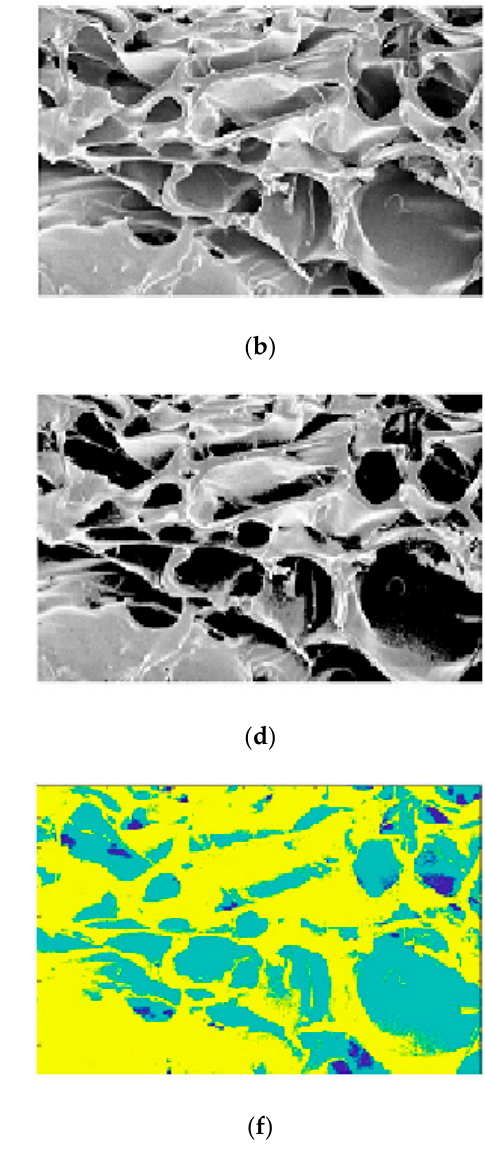
Figure 8. Classification: (Case1) Chitosan image origin ( a ), image enhanced (equalization) ( b ), classification cluster 1 ( c ), classification cluster 2 ( d ), K -means classification (2 classes) ( e ), and K -means classification (3 classes) ( f ).